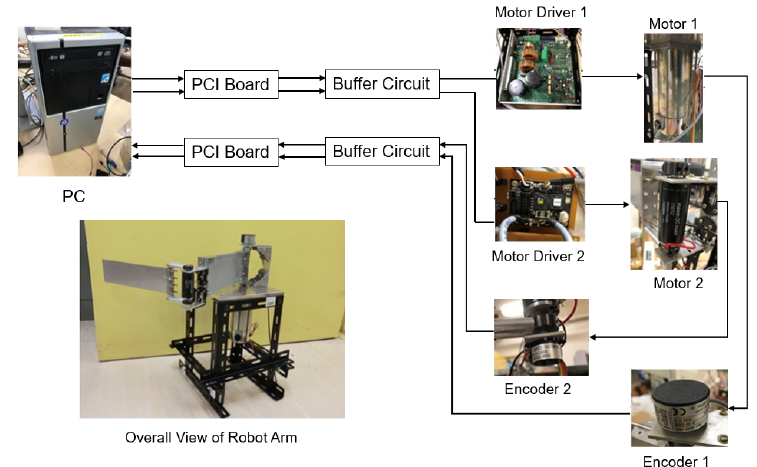
Figure 4. Proposed control